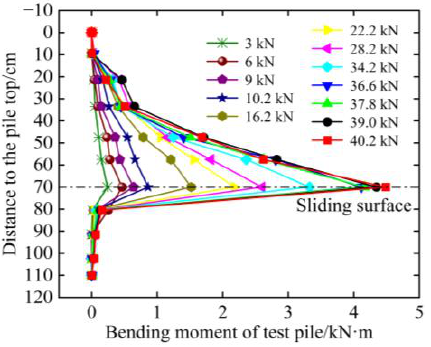
Figure 20. Bending moment distributions along test pile.